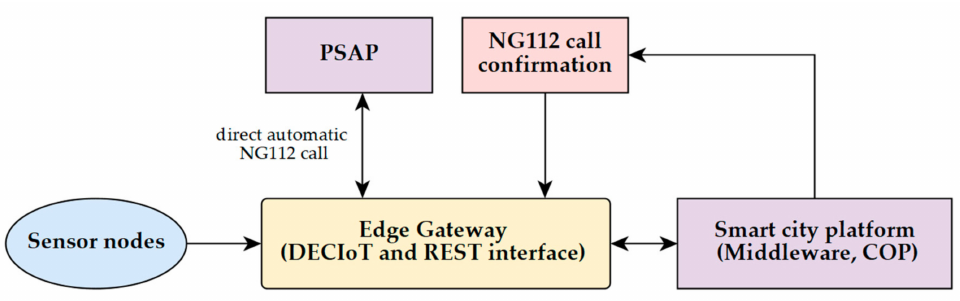
Figure 1. The proposed SB112 prototype